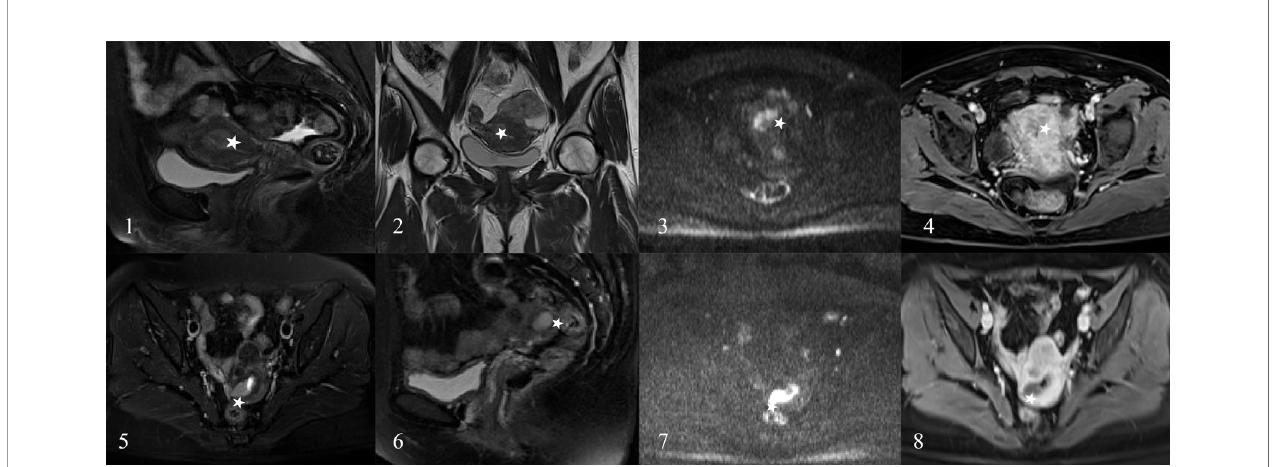
FIGURE 6 | The EC patients misjudged by radiologists. A 45-year-old woman (images 1 to 4) and a 43-year-old woman (images 5 to 8) who were diagnosed as the DMI by radiologists (stars) and diagnosed as super fi cial myometrial invasion (SMI) by the radiomics nomogram and proven the SMI by pathology.